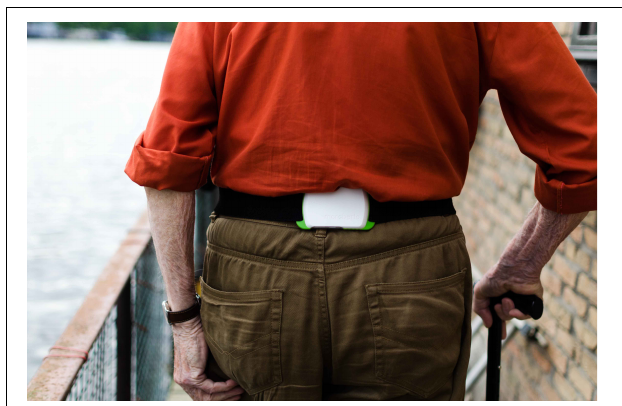
FIGURE 1 | Sensor positioned on the low-back